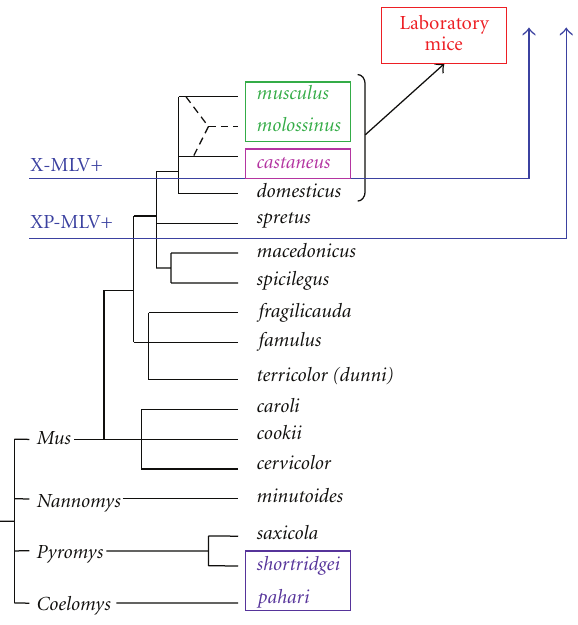
Figure 6: Phylogenetic tree of Mus . Blue arrows indicate the species that have acquired XP-MLV ERVs, and the subset that have predominantly X-MLVs. 4 colored boxes identify the mice carrying the 4 restrictive Xpr1 alleles; all other species carry the permissive Xpr1 sxv